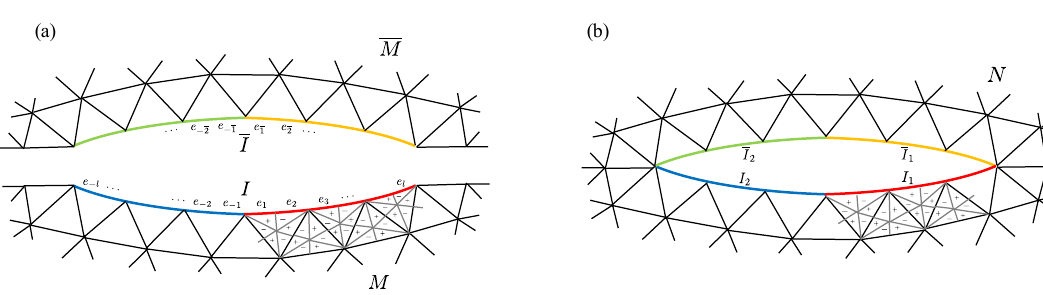
Figure 3 . (a): j in i and h out j are prepared by the path integral on M and M respectively. (b): taking the partial trace amounts to gluing M and M , and the resulting surface is denoted as N